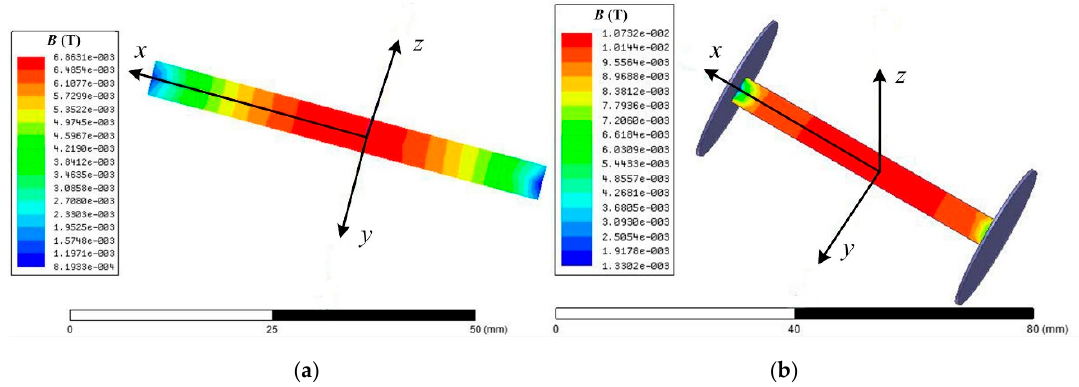
Figure 4. Magnetic induction distribution of magnetic core in a constant magnetic field. ( a ) Without magnetic flux concentrator. ( b ) With magnetic flux concentrator.